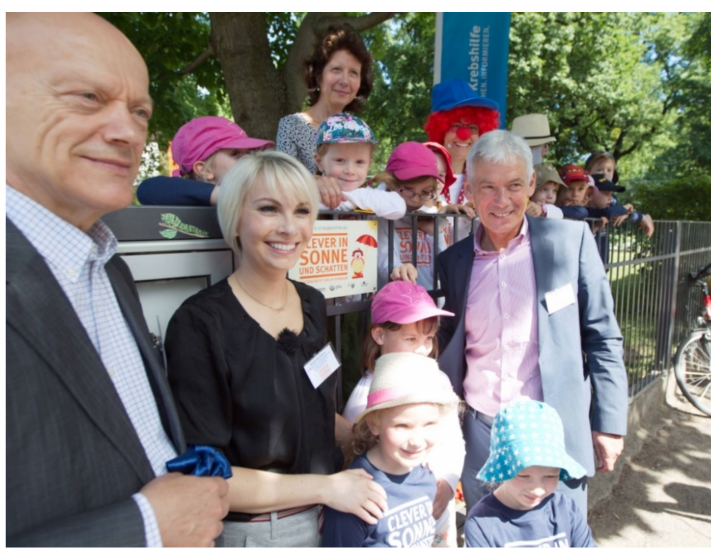
Figure 9. The first of more than 250 CLEVER Awards © Deutsche Krebshilfe